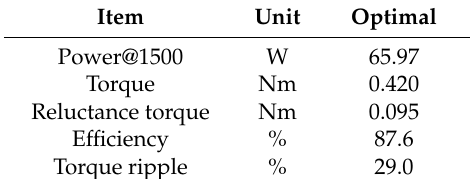
Table 3. Analysis results of optimal model.